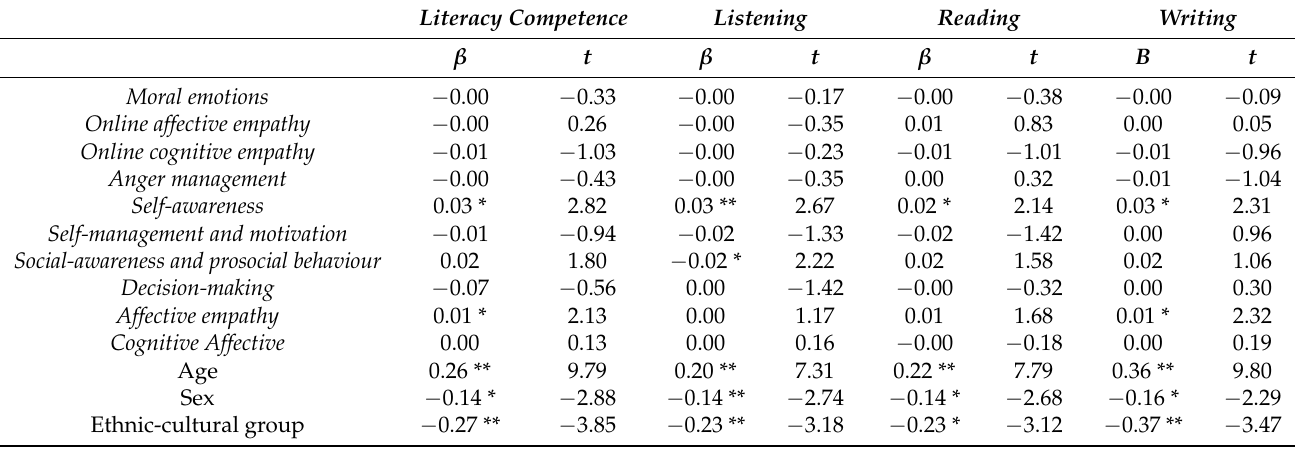
Table 3. Linear regression analyses with moral emotions , online empathy , anger management , socio-emotional competencies , empathy, and personal variables (age, gender, and ethnic-cultural group membership) as cross-sectional predictors of literacy competence ( n = 516).